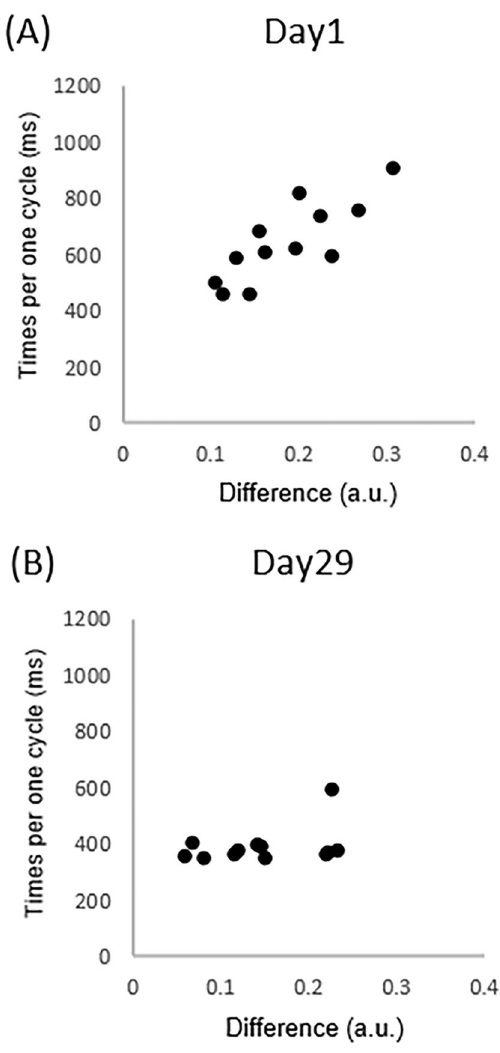
Figure 4. ( A ) Relationship between the difference in digit coordination pattern and the time spent for one cycle on day 1 ( p = 0.0013, r = 0.81). ( B ) Relationship between the difference in digit coordination pattern and the time spent for one cycle on day 29 ( p = 0.37, r =